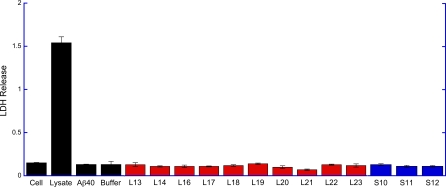
Effect on LDH Release by Hormone FibrilsThe mouse embryo fibroblast cells were treated with fibrils of GnRH-analogs, buffer alone (Buffer), and Aβ(1–40) (Aβ40), and the release of LDH was assayed. The amount of LDH release is shown as arbitrary units (AU). The cell lysate and Aβ(1–40) were used as positive control, whereas cells treated with buffer alone were used as negative control (black bars). Three independent experiments were performed. “S” indicates short-acting (blue bars) and “L” indicates long-acting (red bars) GnRH analogs as labeled in Tables 1, S1, and S2.